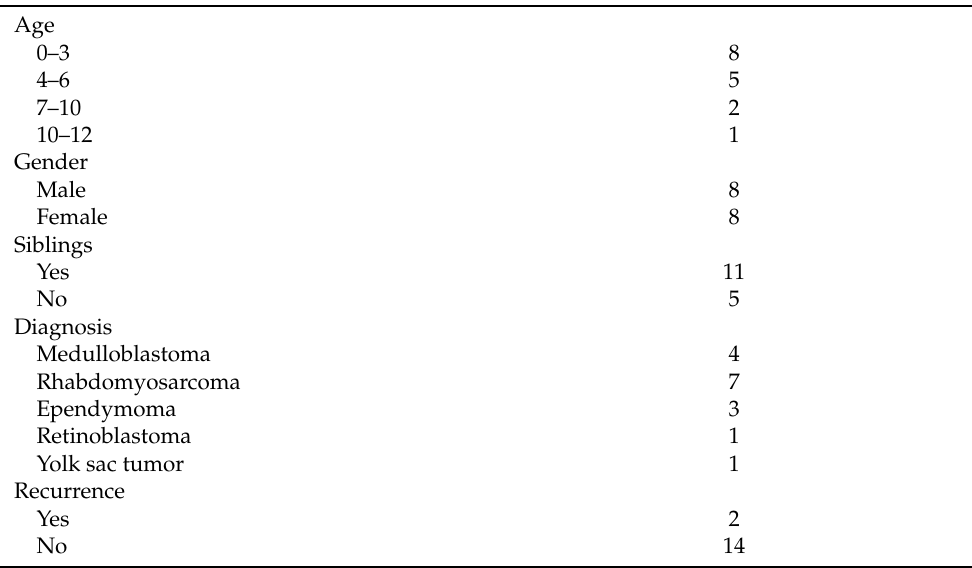
Table 1. Children’s attributes (n =